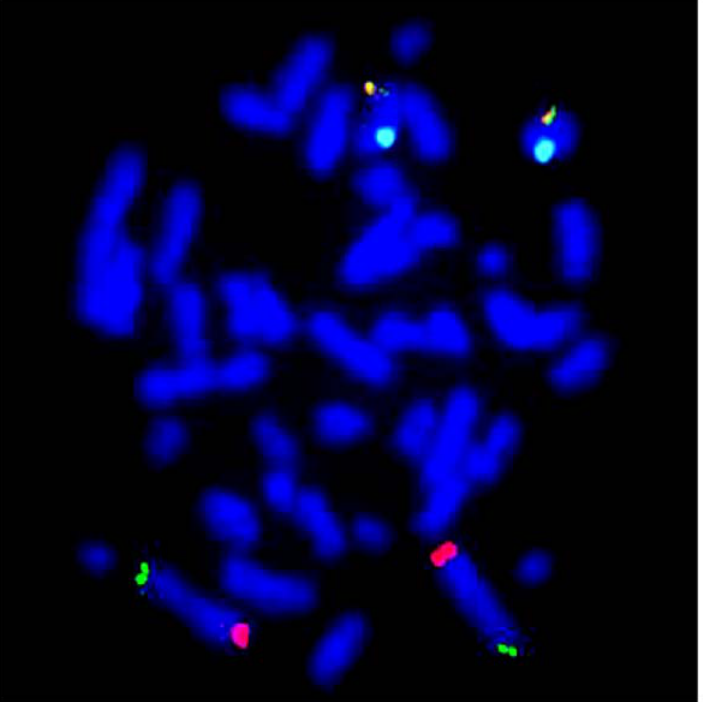
Figure 1. An example of a FISH hybridized metaphase spread. Four different probe signals are visible: 2p (green signal), 2q (red signal), Xq/Yq (yellow signal) and X (aqua signal). This pattern represents the pattern seen in a normal diploid cell from a female.